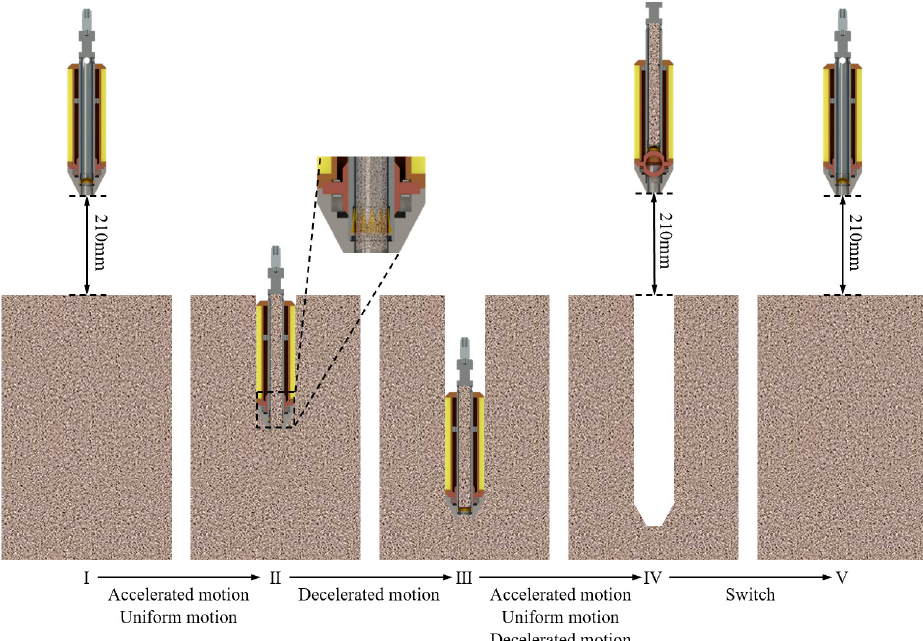
Figure 4. The operation process of the multipoint sampler. Stage I: The eight sampling structures are positioned in the rotary drive by the lower square stopper, followed by the rotation of the torsion spring by 90 ◦ , driven by the ball valves. Further, the sampling tube passes through the ball valve. The ball valve keeps the sampling tube locked using the tension torsion